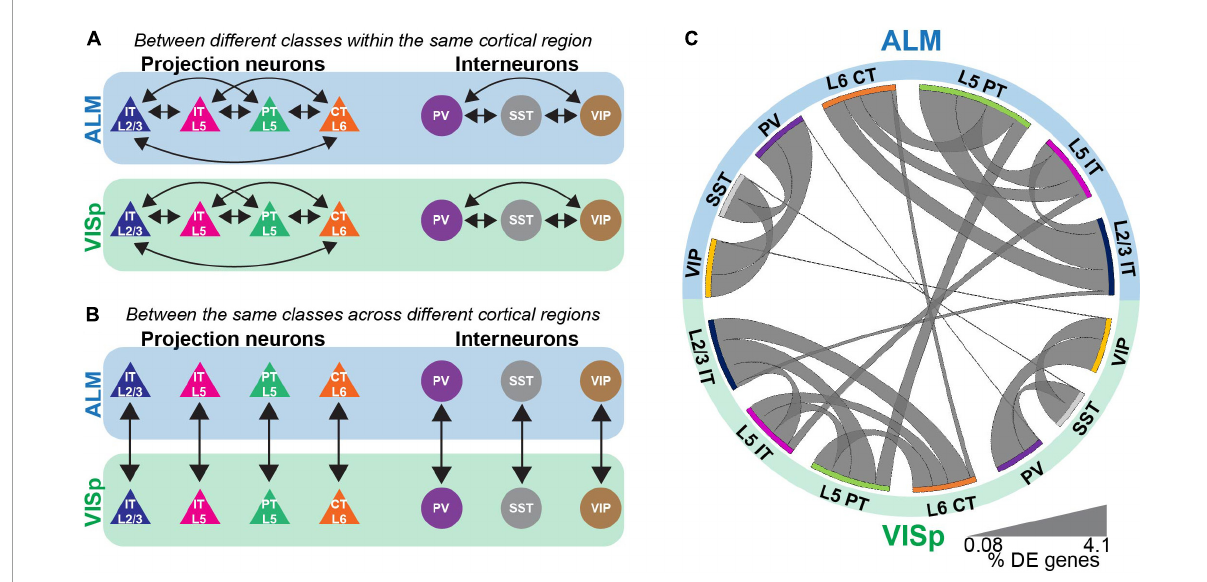
FIGURE2 Differential expression tests for major neuronal classes either within or between cortical regions. (A) Pairwise differential expression tests conducted between excitatory or inhibitory neuronal classes in ALM or VISp. (B) Pairwise differential expression tests conducted between the same neuronal classes across ALM or VISp. (C) Circos plot summary of the percentage of differentially expressed genes found in each pairwise comparison. Classes are listed along the circumference of the plot in their respective brain region (blue - ALM; green - VISp). Bands connect classes that were compared in a pairwise differential expression test. Band thickness represents the proportion of differentially expressed genes in each test: thinner bands indicate a small percentage of distinguishing genes and thicker bands indicate a larger percentage of distinguishing genes.